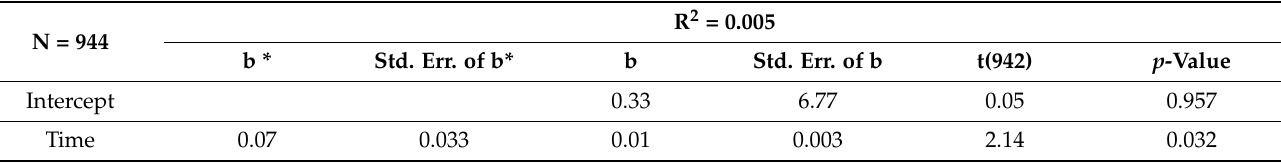
Table 4. Statistical regression analysis for minimum temperature in the Mopani and Vhembe